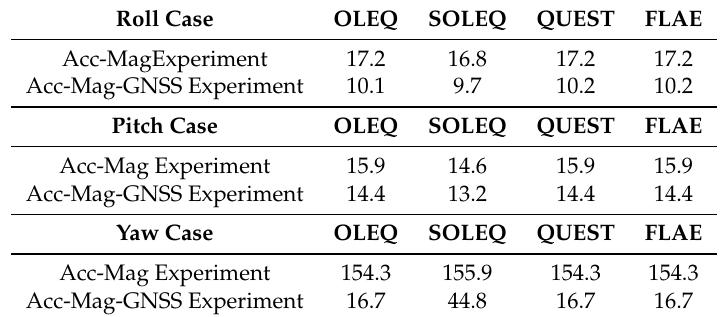
Table 6. RMSEs of the experiment (in deg).